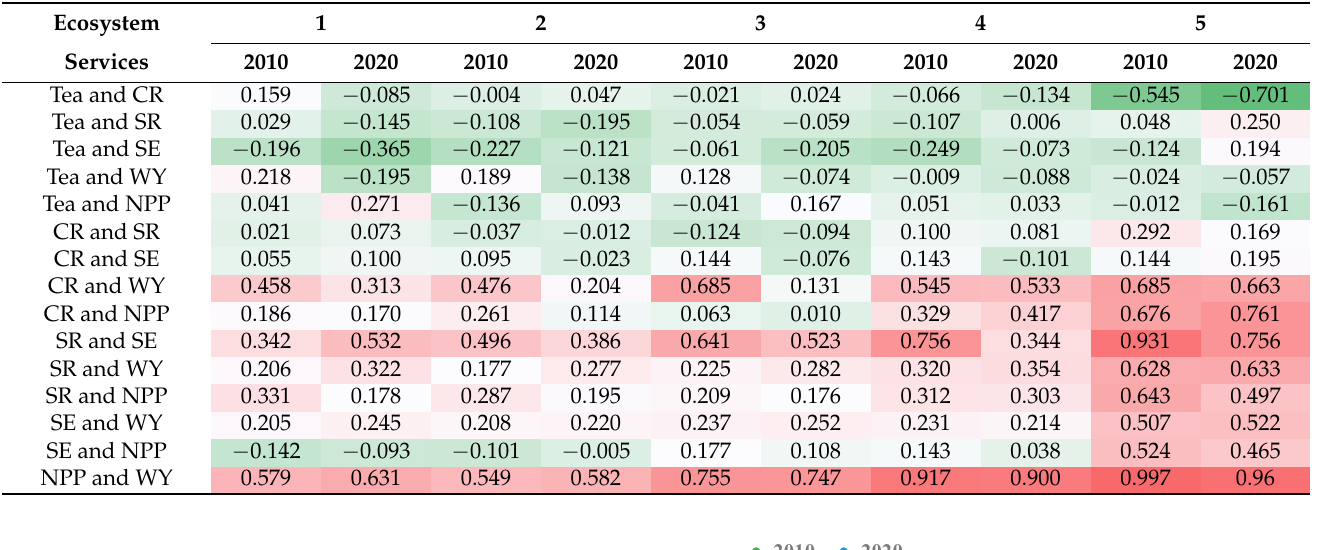
Table 8. Correlation coefficients among ESs of tea garden yield zoning in Fuzhou. Tea: tea production; WY: water yield; CR: climate regulation; SR: soil retention; SE: soil erosion; and CE: carbon emissions. Red indicates a positive Pearson correlation coefficient between ESs; green indicates a negative Pearson correlation coefficient between ESs.